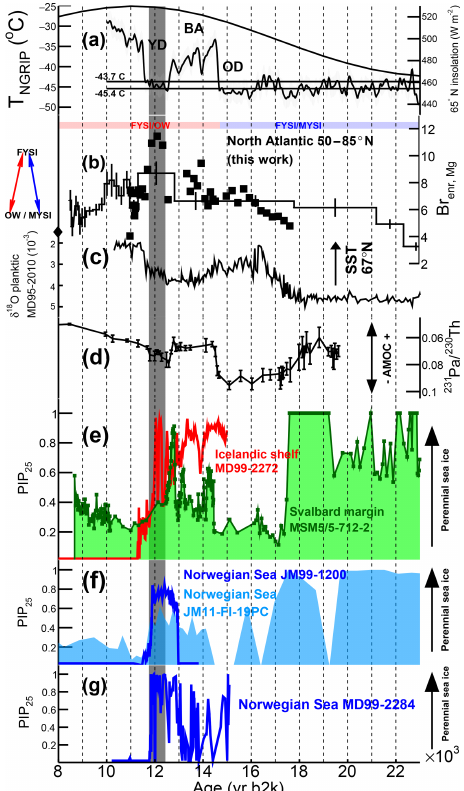
Figure 6. Climate records during the last deglaciation. (a) NGRIP air temperature reconstruction (Kindler et al., 2014) ( ± 1 σ = 2 . 5 ◦ C). The two horizontal lines correspond to a ± 2 σ deviation from the mean temperature ( − 44 . 6 ◦ C) found during the 12.4– 11.8ka period of maximum Br enr , Mg (grey vertical band). The T NGRIP record does not extend before 10ka but the temperature is not expected to cross the threshold at any time in the Holocene. The black line is the 21 June daily mean insolation at 65 ◦ N (Laskar et al., 2004). (b) RECAP Br enr , Mg (thick black line) and repeat sampling conducted at higher resolution (squares). Since for the highly resolved measurements magnesium was not mea- sured, for the calculation of the sea-salt sodium concentrations and the Br enr , Mg values (Eqs. 1–7) we used the magnesium val- ues of the four low-resolution samples. Over the time period cov- ered by the repeat measurements, nssNa (cid:39) 10%–20%. The average Br enr , Mg value measured during the Holocene is indicated by a dia- mond. (c) Planktonic δ 18 O record from sediment core MD95-2010 (66 ◦ 41.05 (cid:48) N, 04 ◦ 33.97 (cid:48) E, from Dokken and Jansen, 1999). Lower δ 18 O values indicate warmer and fresher ocean waters. (d) Record of 231 Pa / 230 Th ratios within a sediment core retrieved in the deep western subtropical Atlantic (33 ◦ 42 (cid:48) N, 57 ◦ 35 (cid:48) W). Sedimentary 231 Pa / 230 Th are believed to reflect Atlantic meridional overturn- ing circulation (AMOC) strength (McManus et al., 2004). (e, f, g) PIP 25 records from the Svalbard margin (green, core MSM5/5- 712-2, Müller and Stein, 2014), the North Icelandic shelf (red, core MD99-2272, Xiao et al., 2017) and the Norwegian Sea (core JM11- FI-19PC from Hoff et al., 2016); core JM99-1200 from Cabedo- Sanz et al. (2013); and core MD99-2284 from Muschitiello et al. (2019). The PIP 25 scale varies from perennial sea ice (PIP 25 ≈ 1) to open-water (PIP 25 ≈ 0) conditions (see Fig. 5). See Fig. 1 for the PIP 25 core